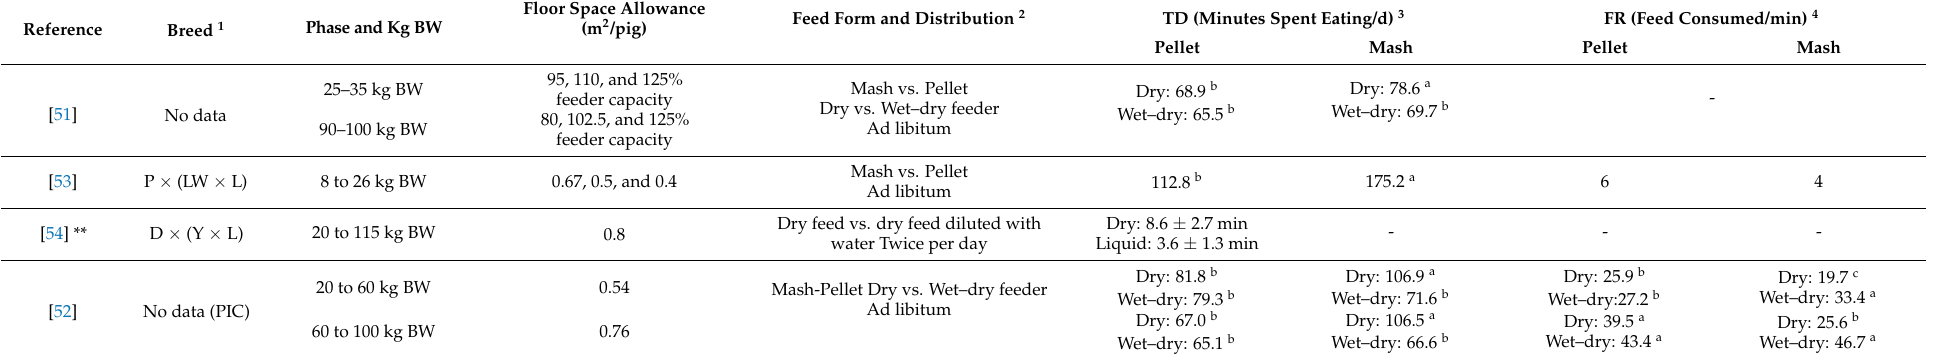
Table 4. The effect of feed form on the feeding behaviour habits of growing-finishing pigs.